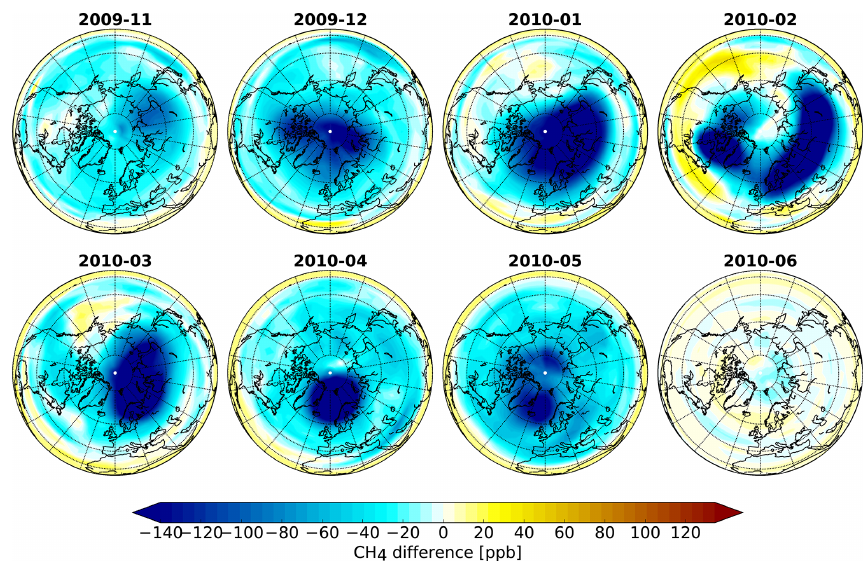
Figure 7. Monthly mean difference in CH 4 (ppb) at 50hPa (north pole projection) between the GEOS-Chem 2 ◦ × 2 . 5 ◦ and 4 ◦ × 5 ◦ simula- tions.